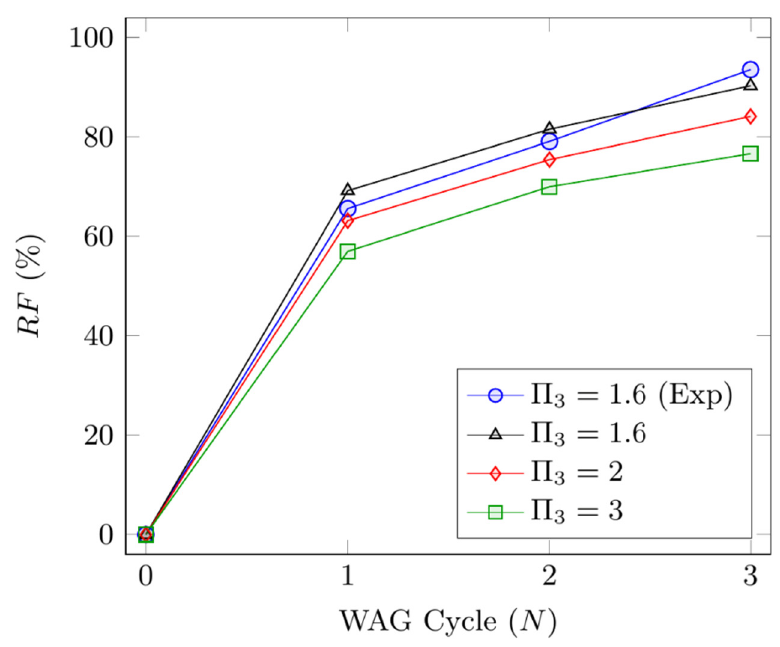
Figure 10. Effect of oil to water viscosity ratio ( π 3 ) on the recovery performance of near-miscible WAG injection based on the developed correlation.